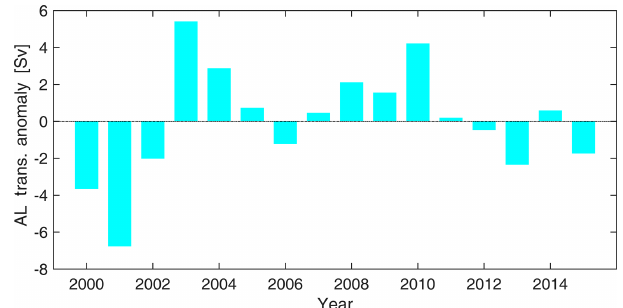
Figure 6. Computation of Agulhas Leakage transport anomaly from the SODA velocity field along the Good Hope line. Note that the depth integration is only for the AAIW